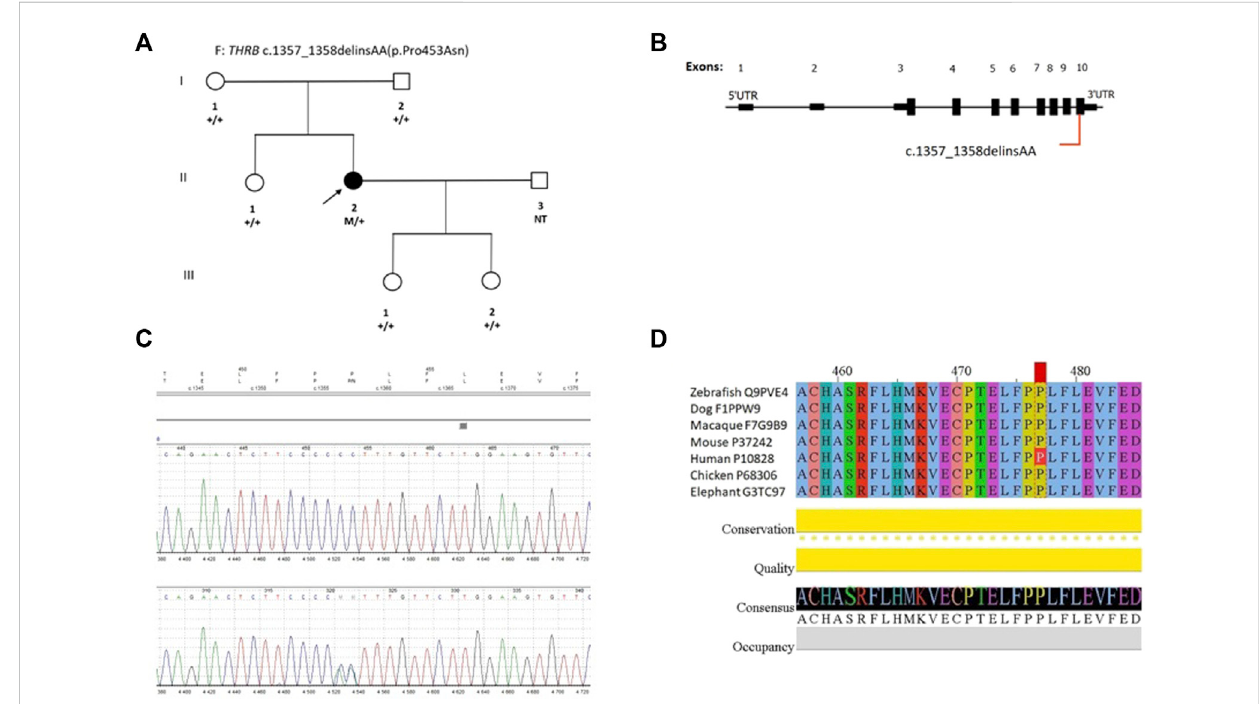
FIGURE 1 Identi fi cationofthenovel THR β mutation. (A) Pedigreeoftheprobandharboringthenovel THR β mutation(p.Pro453Asn).Theprobandharboring de novo heterozygous mutation is identi fi ed by the arrow. Circles denote female members; squares denote male members. The sequencing results for the c.1357_1358delinsAA (p.Pro453Asn) mutation are noted below the corresponding individual. M, mutation; NT, not tested. (B) Schematic presentation of THR β gene; variant ’ s position identi fi ed in this study is indicated in red. (C) Results of direct DNA sequencing for THR β mutation in the proband. (D) UniProt alignment of the THR β region containing the variant identi fi ed in this study and amino acid variations across species from zebra fi sh to